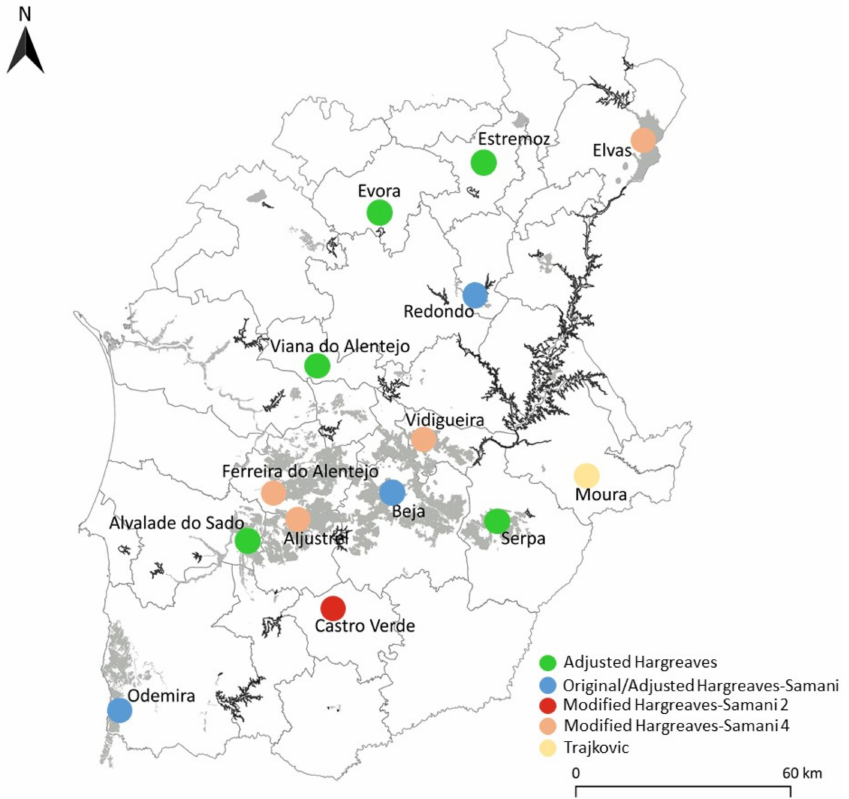
Figure 4. Most suitable method for each